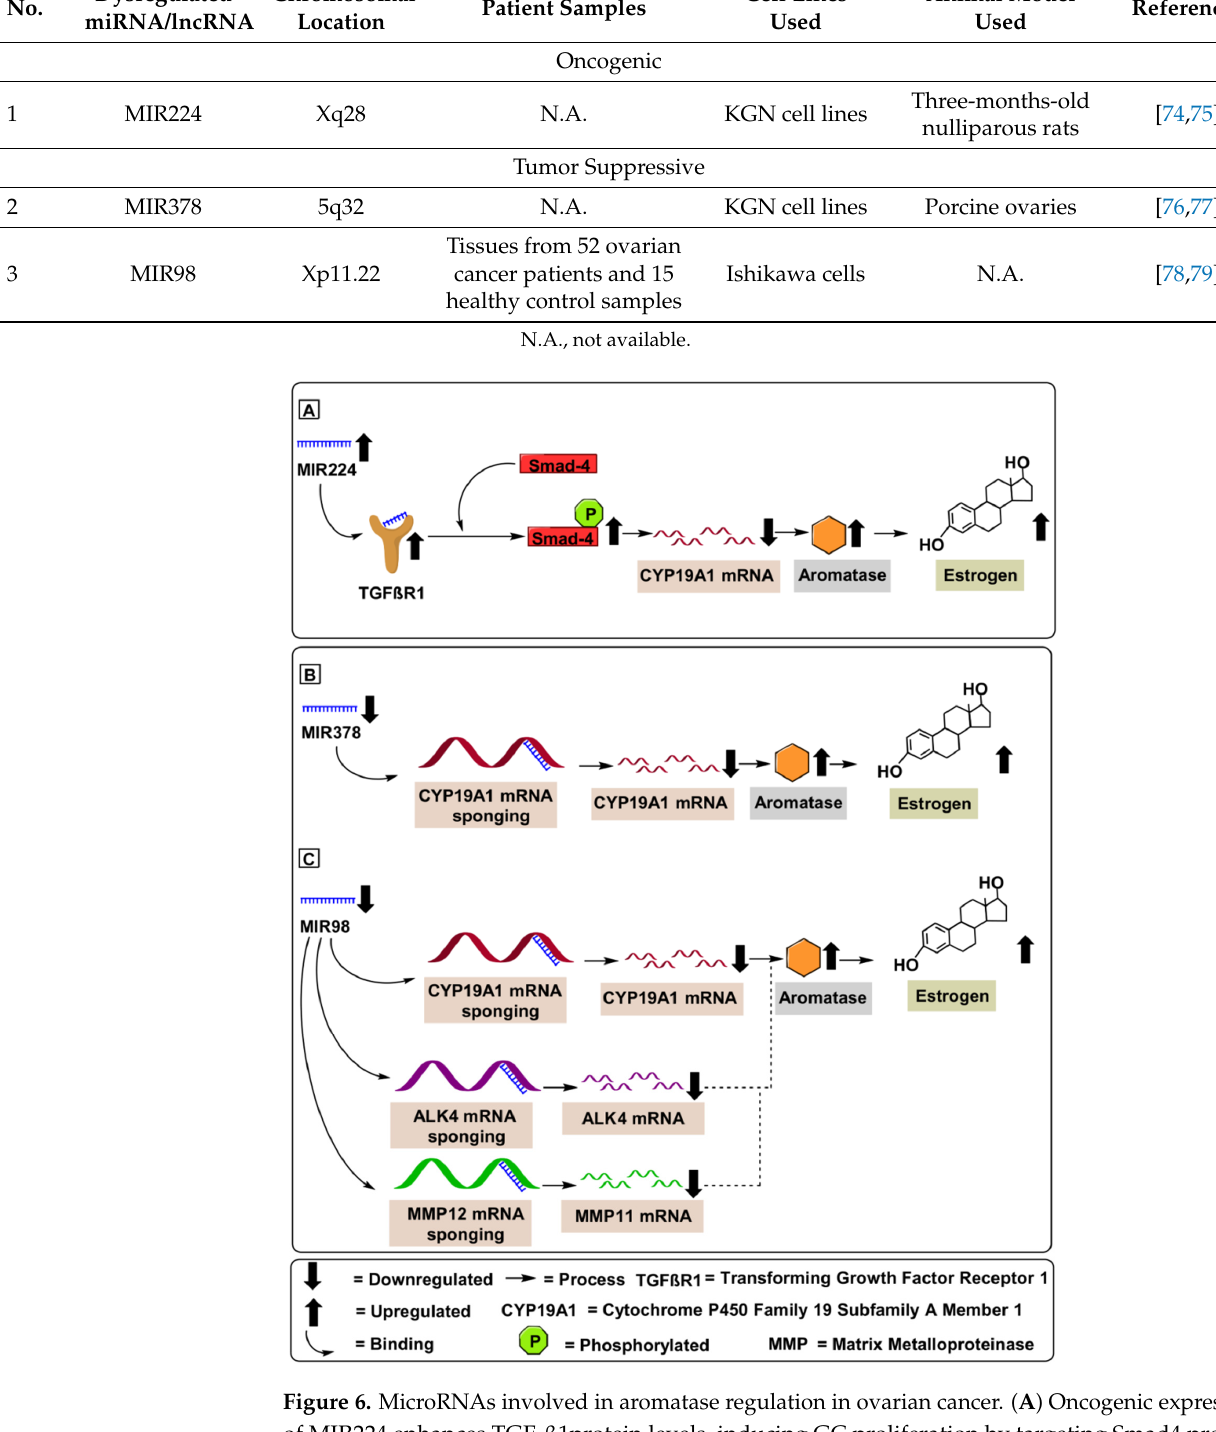
Table 2. Dysregulated miRNAs associated with aromatase dysregulation in ovarian cancer. S. No.